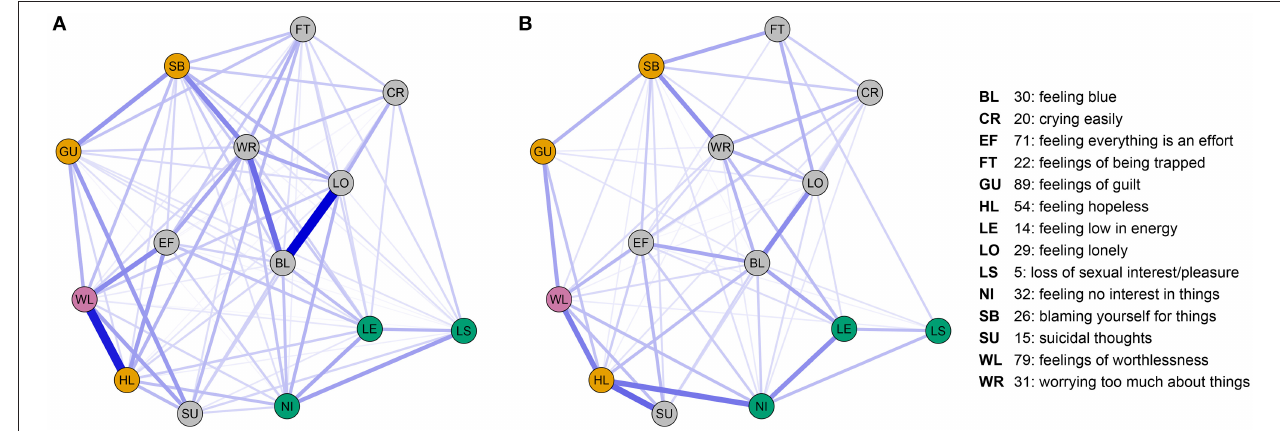
FIGURE 1 | (A) SCL90 depression-relevant symptom network obtained from Study 1; (B) SCL90 depression-relevant symptom network obtained from study 2. Displayed networks comprise nodes (questionnaire items) and edges (non-zero eLasso network weights). Edges correspond to the regularized strength of the association between items adjusted for the associations between all other items in the network. Nodes are colored by their hypothesized role: worthlessness (pink), Reduced Positive Affect items (green), Revised Learned Helplessness items (yellow), other items (gray). Node positions are identical between studies to aid comparison of the networks. Node position was determined by a force-directed “spring” layout of the average weights taken over study 1 and study 2. Non-zero network edges are displayed in blue using a consistent size/transparency scale over the two